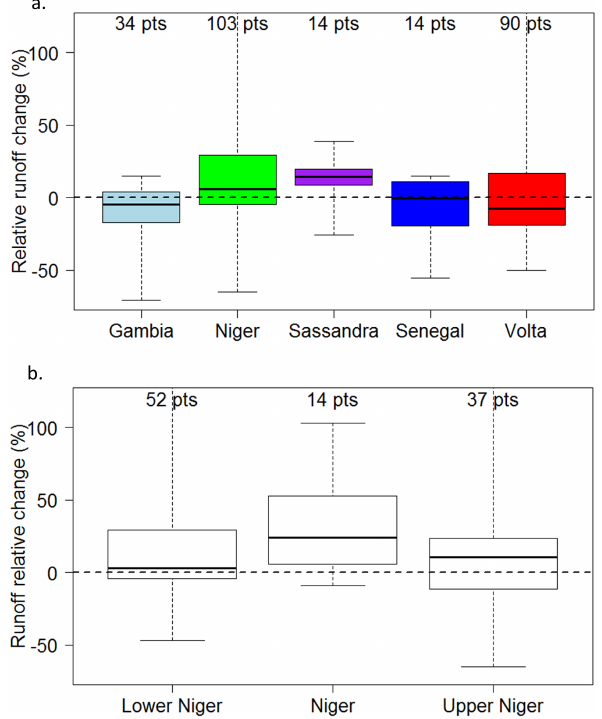
Figure 4. (a) Impact of climate change on runoff (%), by river. Some previous clustering has been done (e.g., Bani and Benue are included with Niger and all the Volta tributaries are together). (b) Runoff relative change (%) for different parts of the Niger River, according to the database. When only Niger is specified, this means that there is no description (upper or lower Niger) in the original